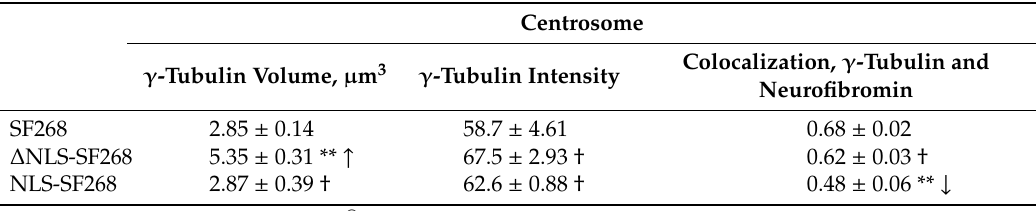
Table 2. Quantitative intensity of γ -tubulin and neurofibromin isoform colocalization analysis in cells modified for expression of NF1 transcripts.